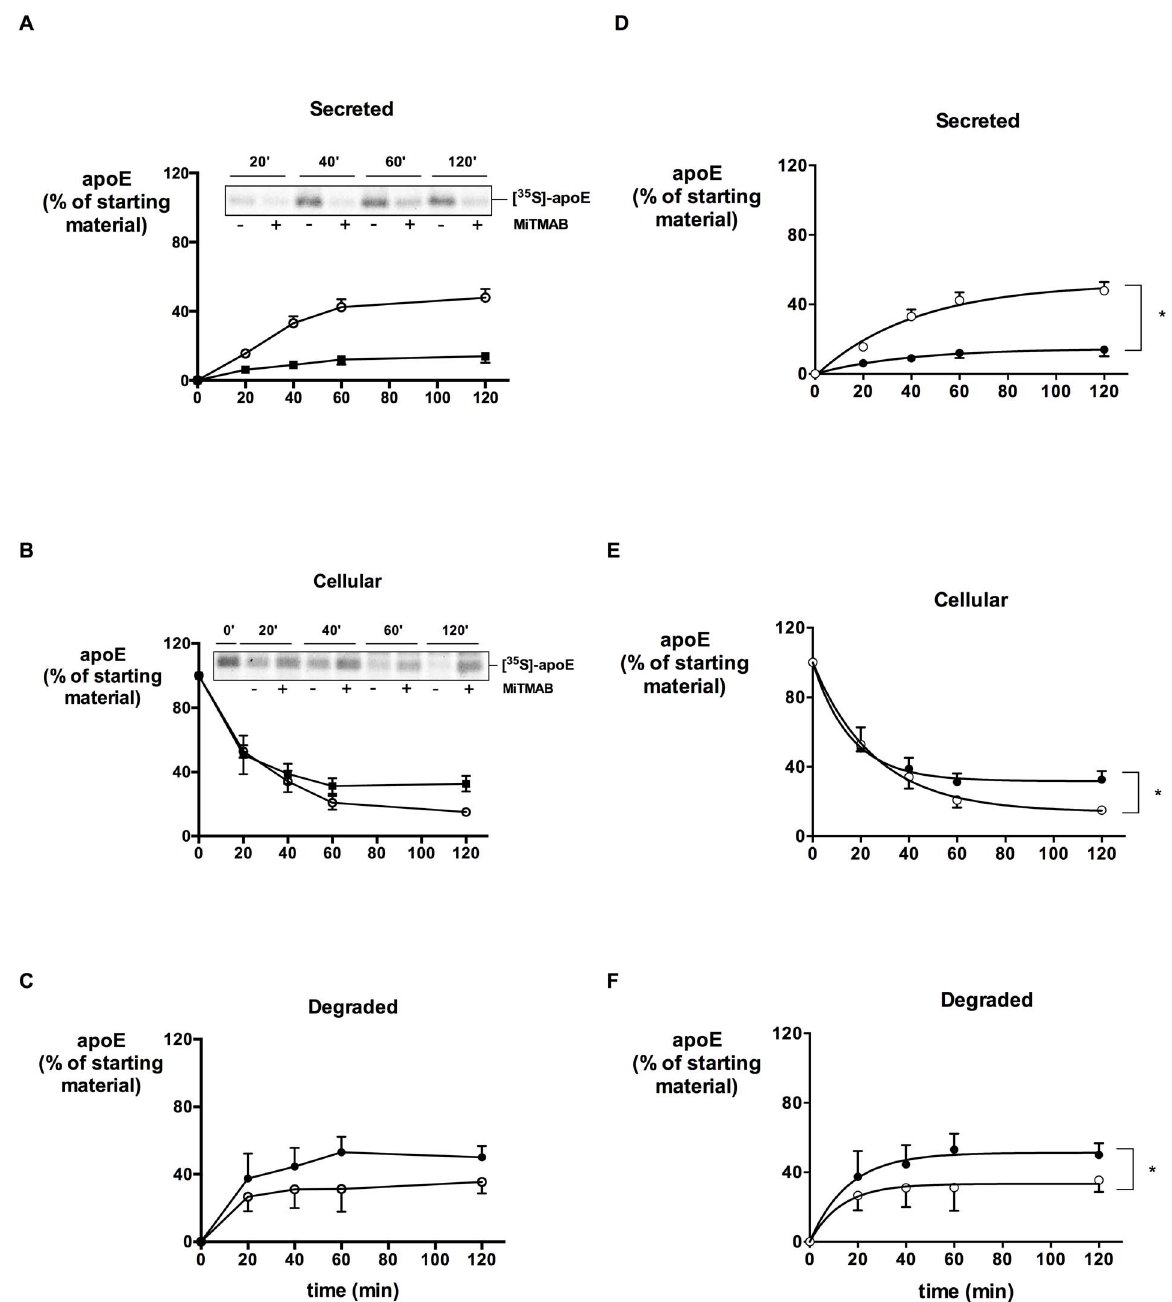
Figure 4. Dynamin inhibition affects secretion and degradation of pre-labeled [ 35 S]-apoE. HMDM were incubated in methionine/cysteine free DMEM with 250 m Ci/mL [ 35 S]methionine/cysteine for 3 h and received a preincubation with or without 30 m M MiTMAB during the last 30 min. Cells were then washed and chased in medium containing unlabelled methionine/cysteine, without or with 30 m M MiTMAB. At the indicated times [ 35 S]-labelled apoE was immunoprecipitated from media and cell lysates, separated by SDS-PAGE and quantified by phosphorimaging. Secreted [ 35 S]- apoE (A); cell-associated [ 35 S]-apoE (B); net degradation of [ 35 S]-apoE (C), calculated by subtracting residual [ 35 S]-apoE in cell and media from [ 35 S]- apoE at T 0 . Inserts show representative images. Fitted data according to Eq1 are shown (D–F). Symbols Ctrl ( # ) and MiTMAB ( experimental data. * P , 0.05 between treatments (Repeated Measures 2-way